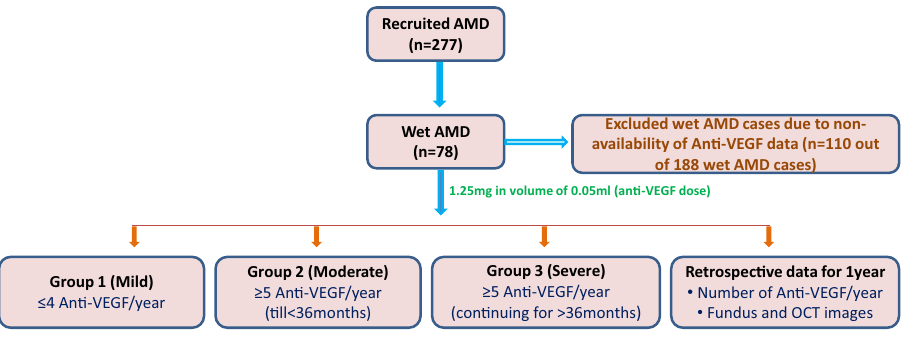
Figure 1. Schematic representation of groups categorised in